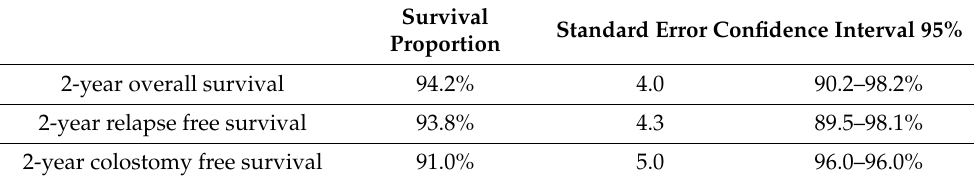
Table 2. Efficacy